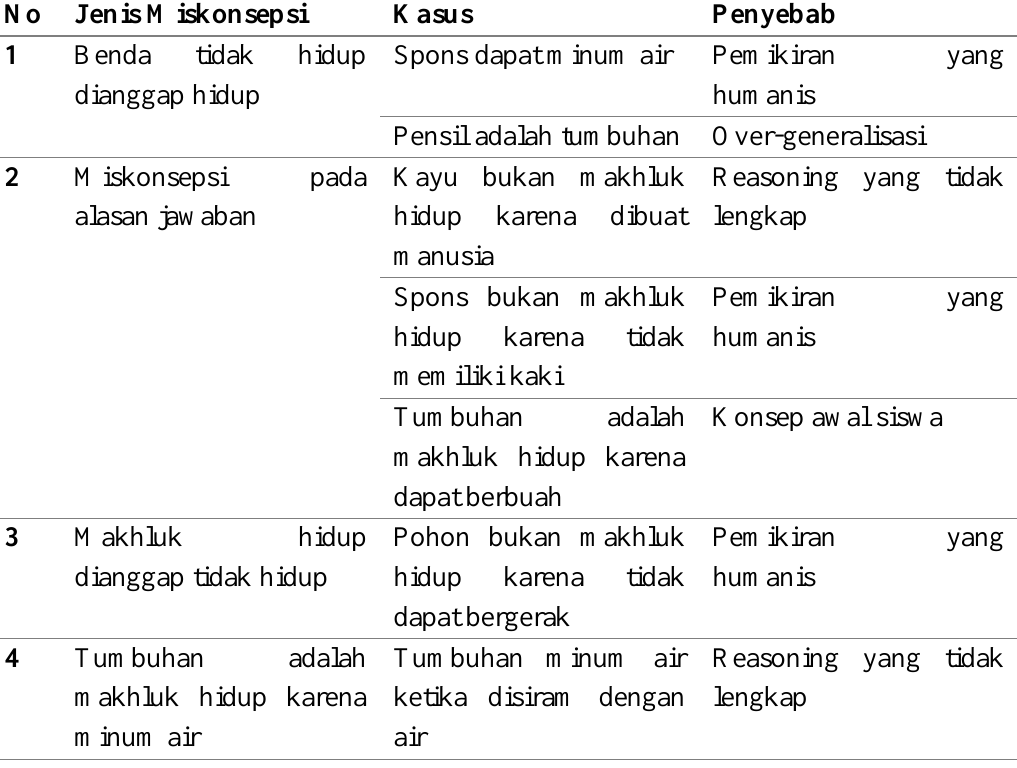
Tabel 1. Miskonsepsi Siswa SD pada Materi Concept of